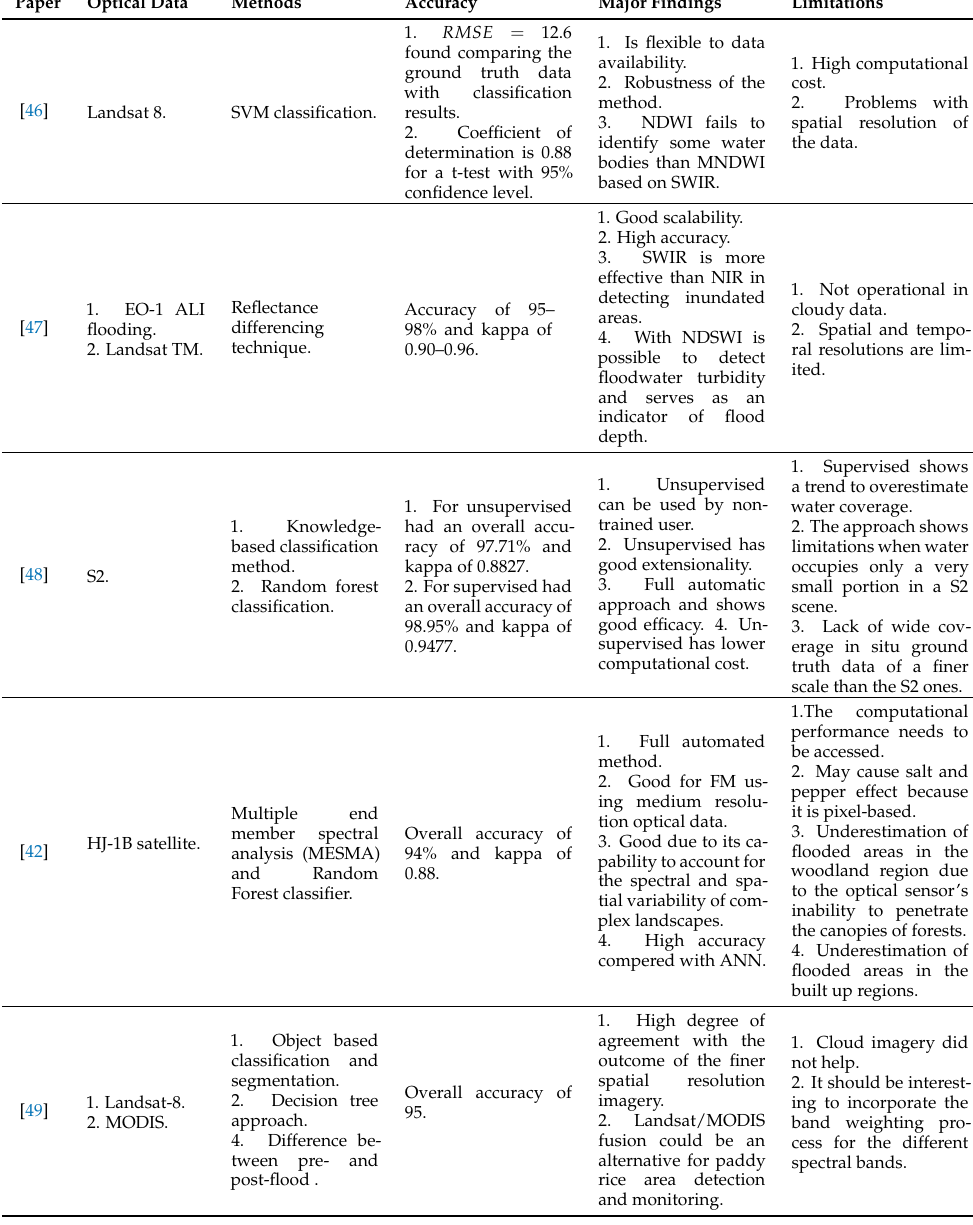
Table 2. Examples of papers about FM using optical